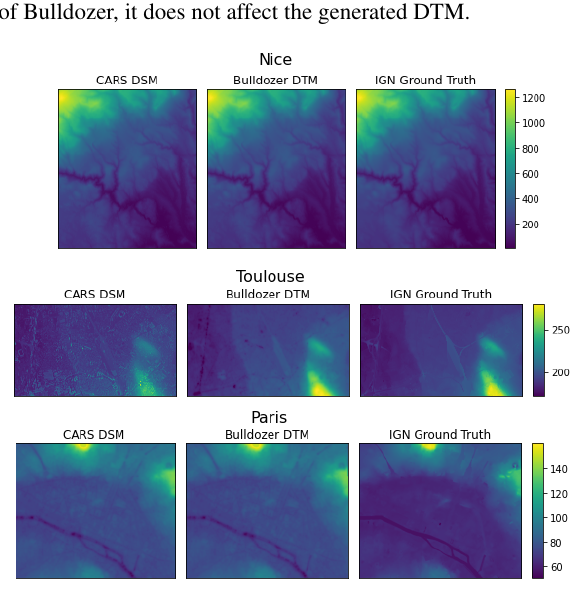
Figure 13. DSM, computed DTM and ground truth for each area used in the benchmark. Top: Nice, Middle: Toulouse, Bottom: